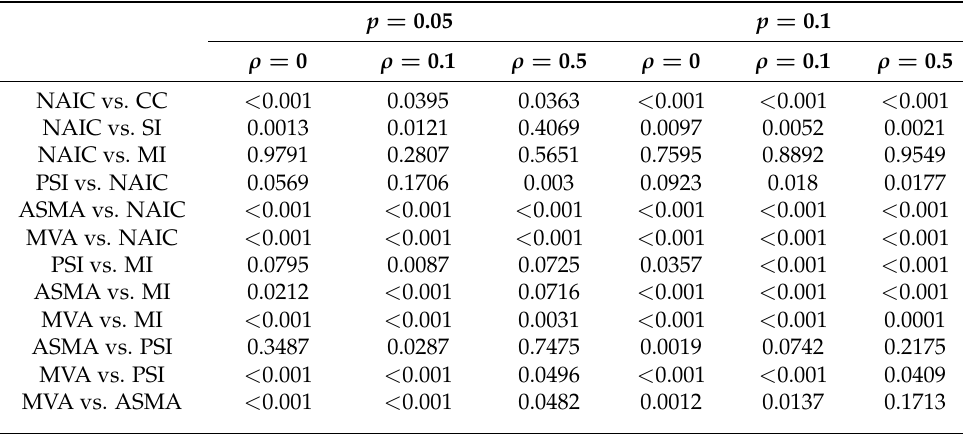
Table A2. Two-tailed paired t -test.